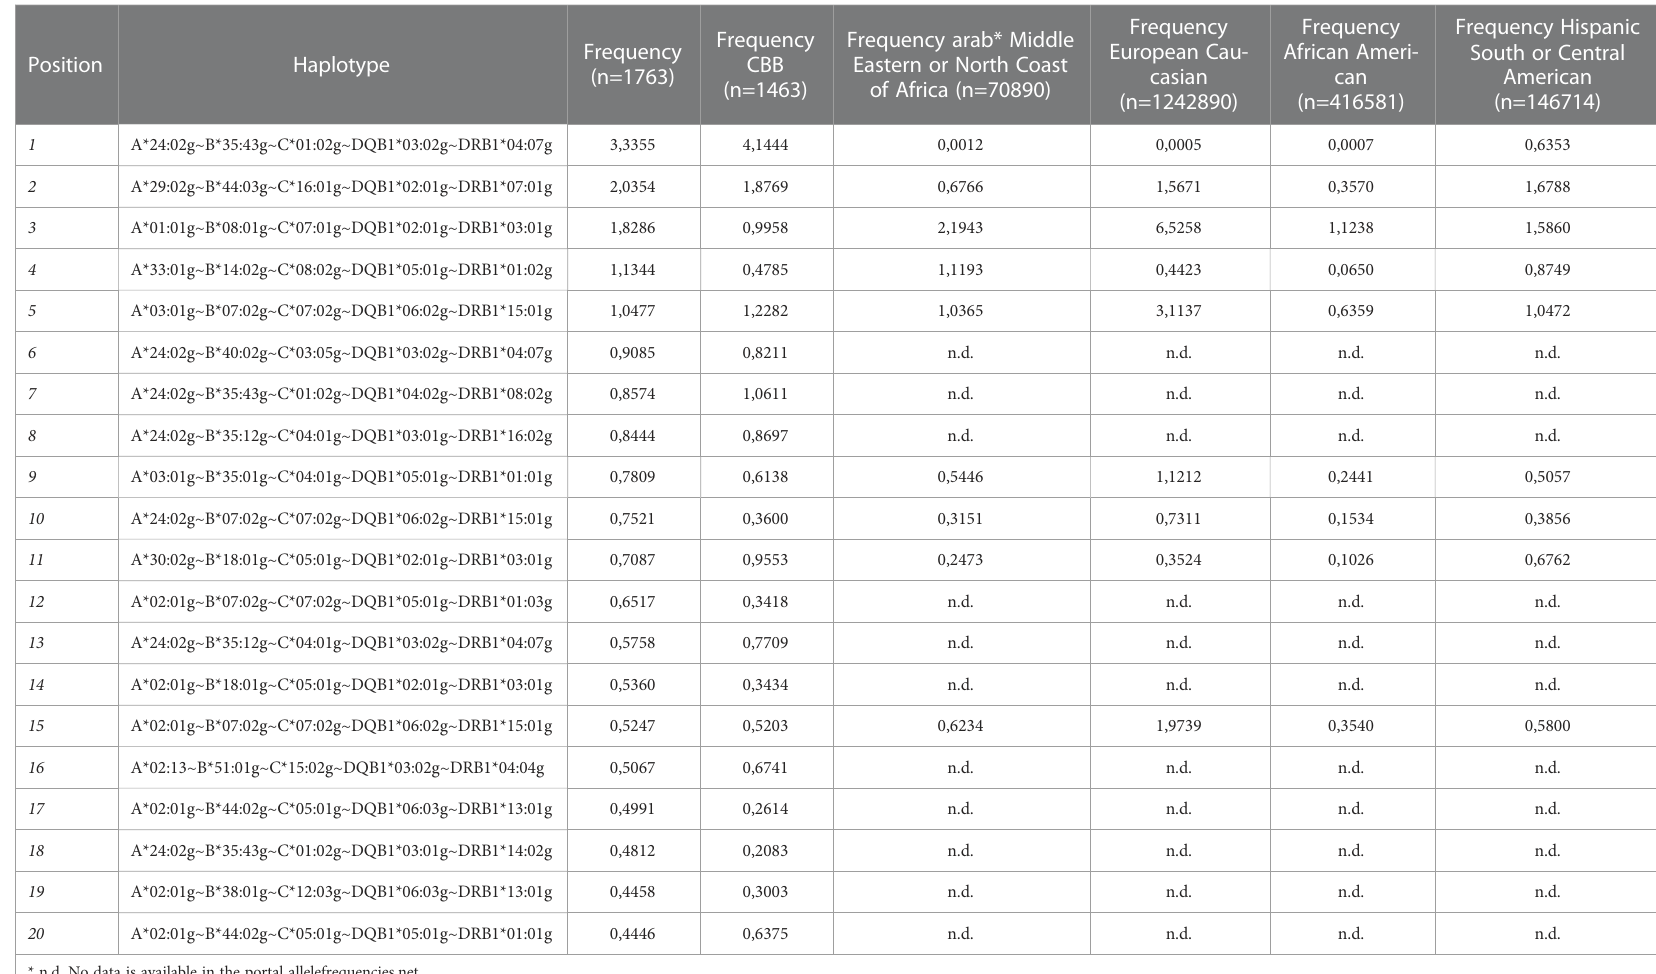
TABLE 3 The 20 most frequent A~B~C~DQB1~DRB1 haplotypes were identi fi ed for the donors from the Colombian BM Donor